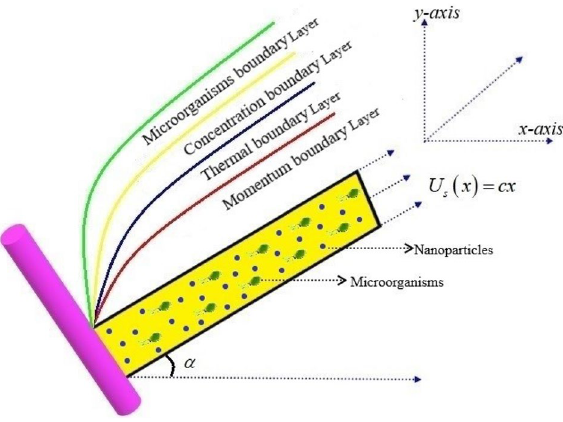
Figure 1. Flow pattern of the